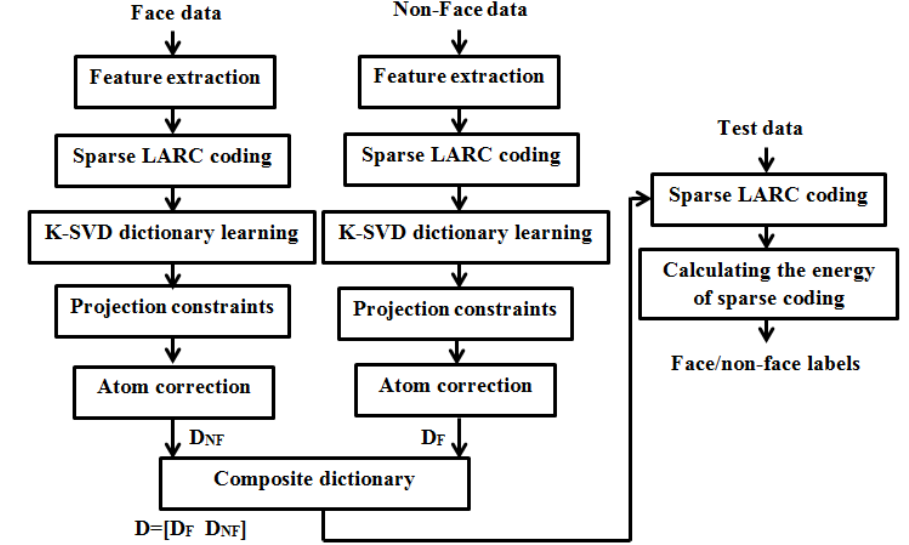
Figure 2. A block diagram of the proposed face detection method based on the learning incoherent